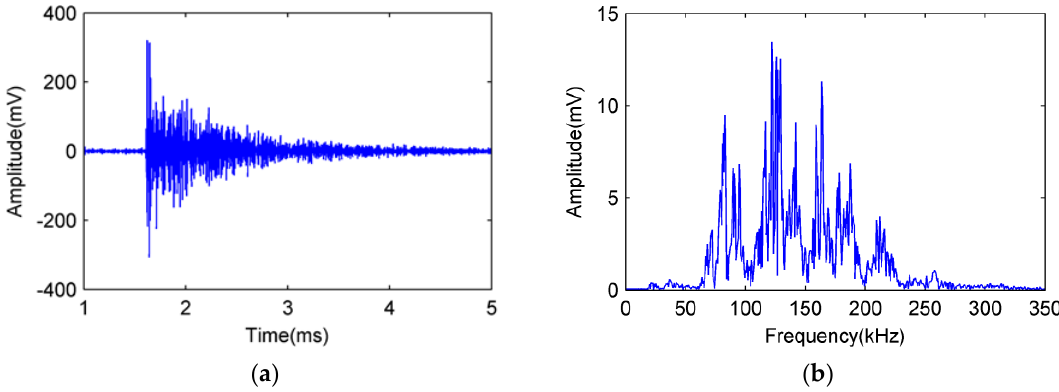
Figure 11. Broken lead signal detected by FOR AE sensor. ( a ) Time domain diagram; ( b ) Frequency domain diagram.